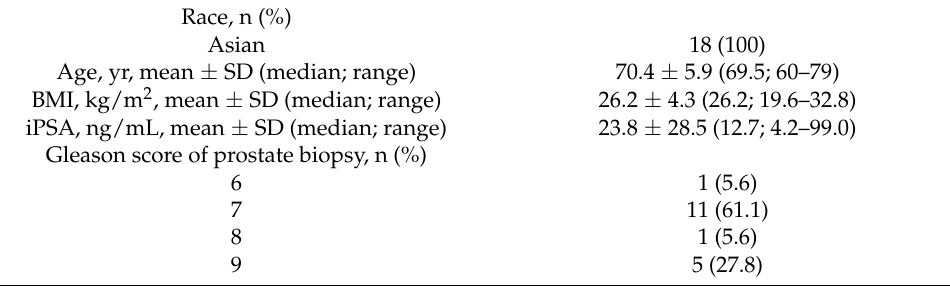
Table 1. Baseline patient characteristics of cases treated with male sling (n =